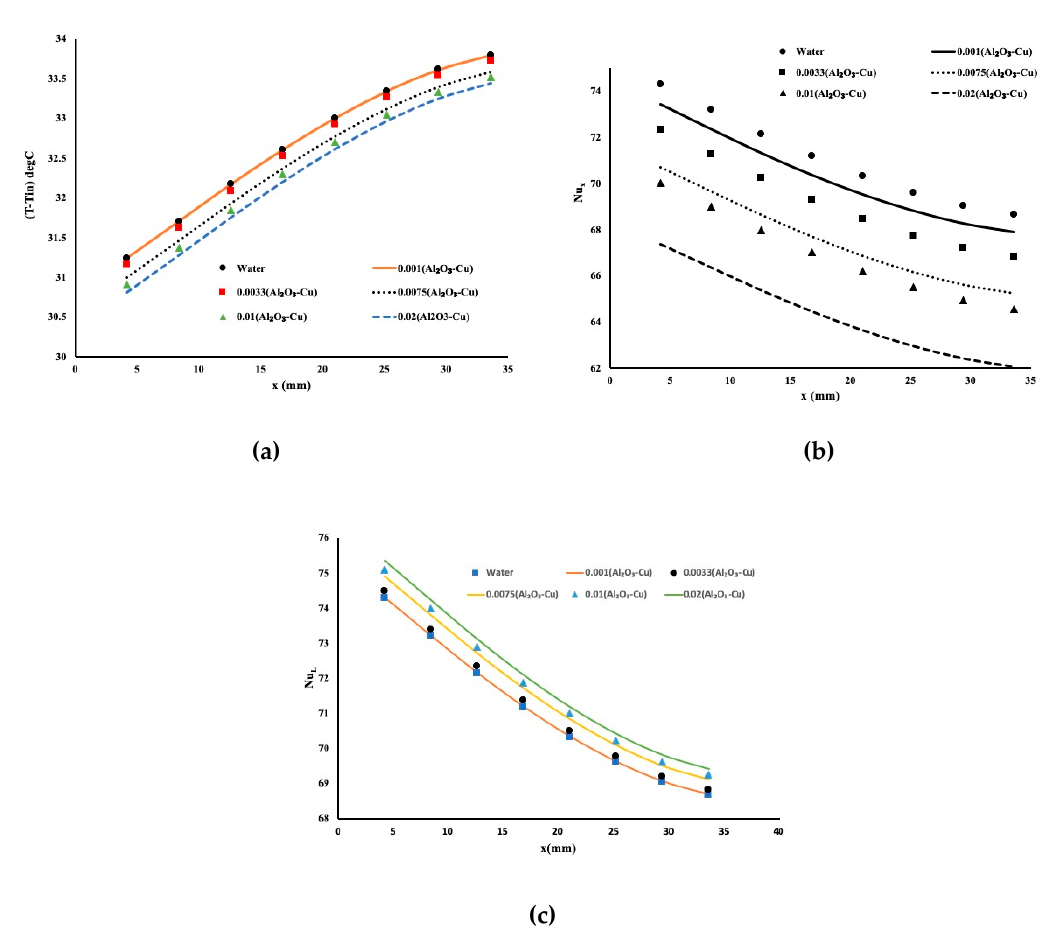
Figure 3. Heat enhancement using the Al 2 O 3 –Cu in water mixture. ( a ) Temperature variation along the flow, ( b ) Nusselt number of each individual mixture, ( c ) Nusselt number using standard